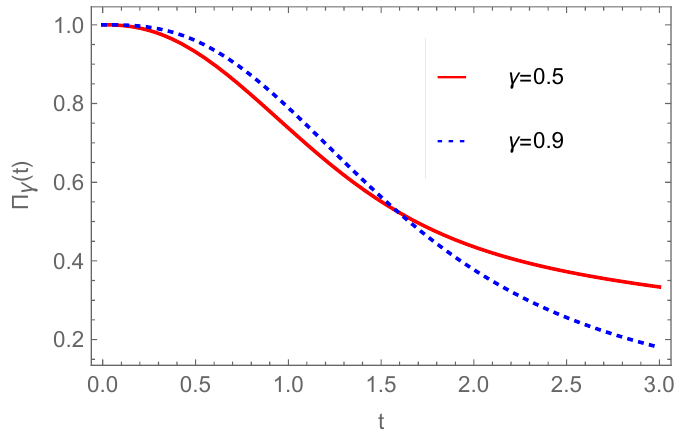
Figure 11. Equation (59) for different values of γ